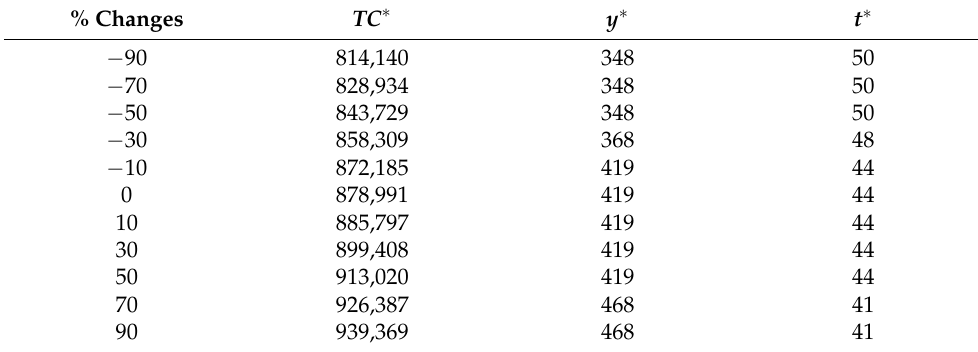
Table 7. Sensitivity analysis of the tax of CO 2 production ( a ).